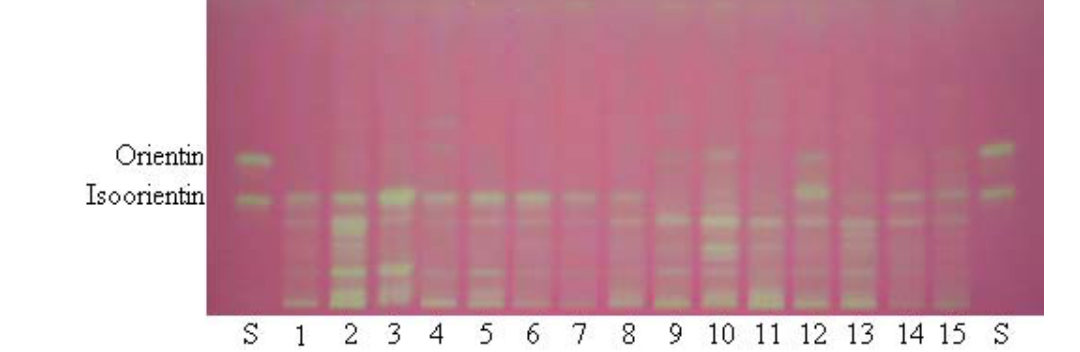
Figure 1. Typical TLC photography of standards and extracts from the different species of bamboo colorized with 0.05% DPPH. S: Standards are isoorientin and orientin. The different bamboo species (No. 1–15) are listed in Table 1.